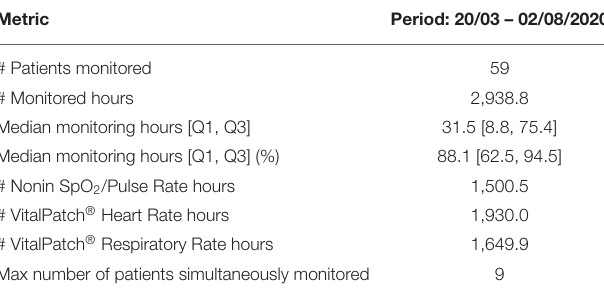
TABLE 3 | Statistics on the vHDU system usage in the John Radcliffe Hospital isolation ward, between the 20th of March and the 2nd of August 2020.